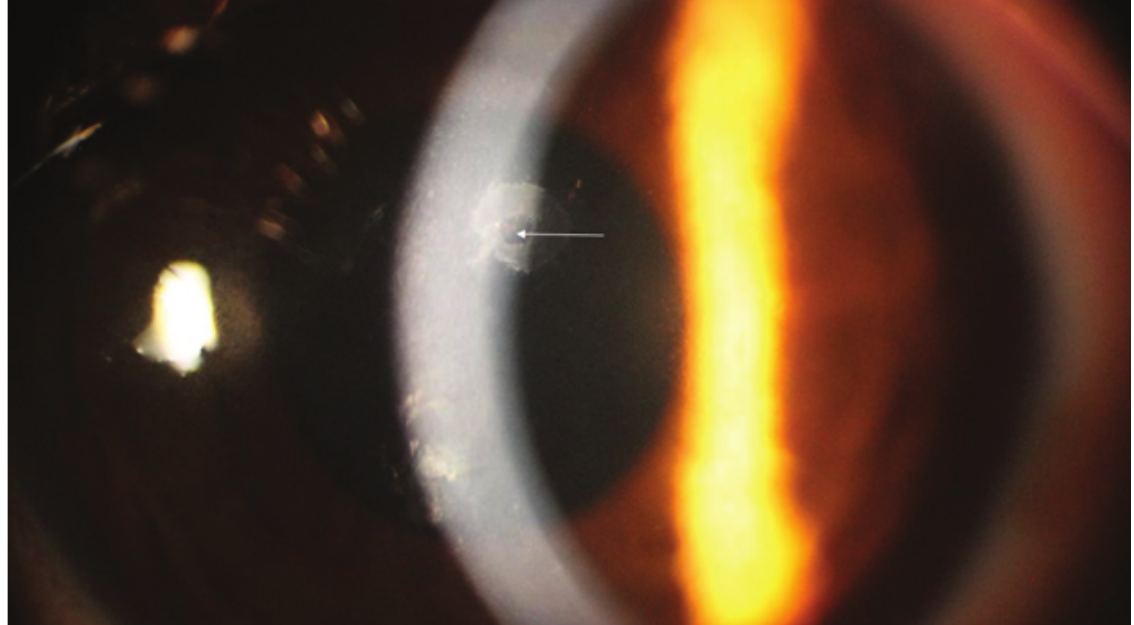
Figure 2. At higher magnification, central healthy endothelial cells are surrounded by a well-defined ring shape